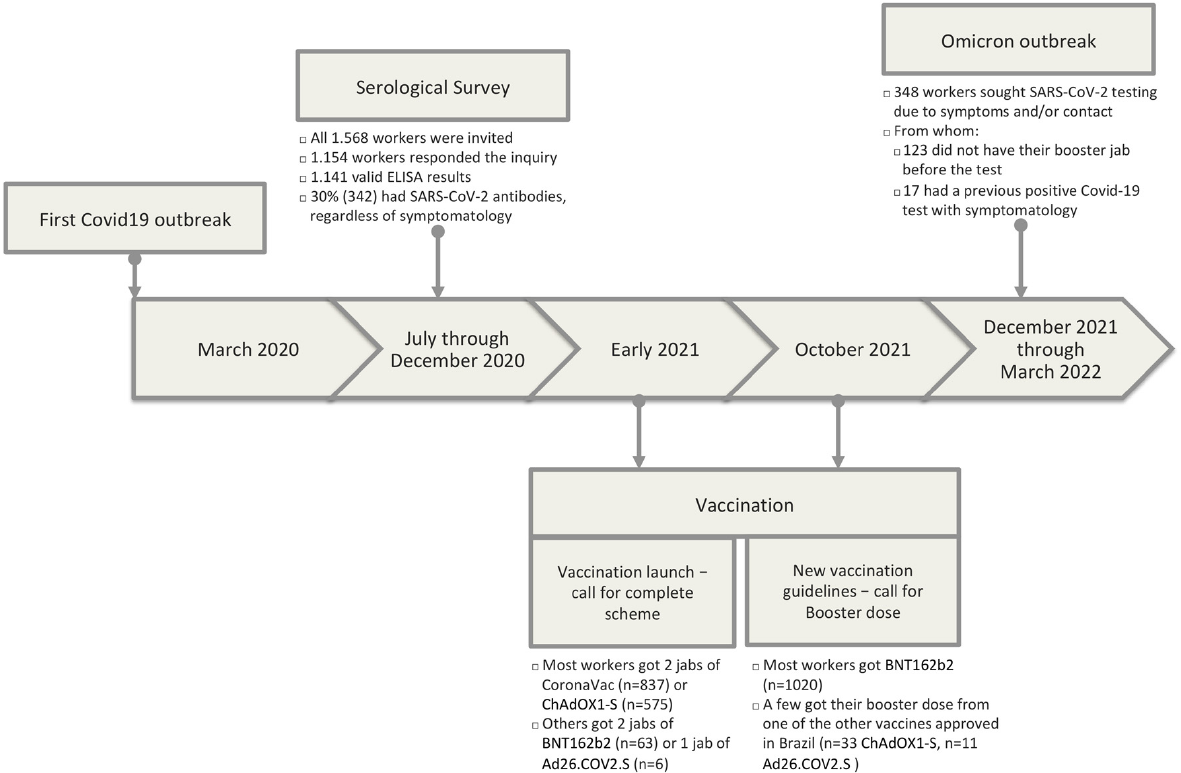
Figure 1. Study timeline depicting related pandemic events and number of workers in each inclusion criteria.